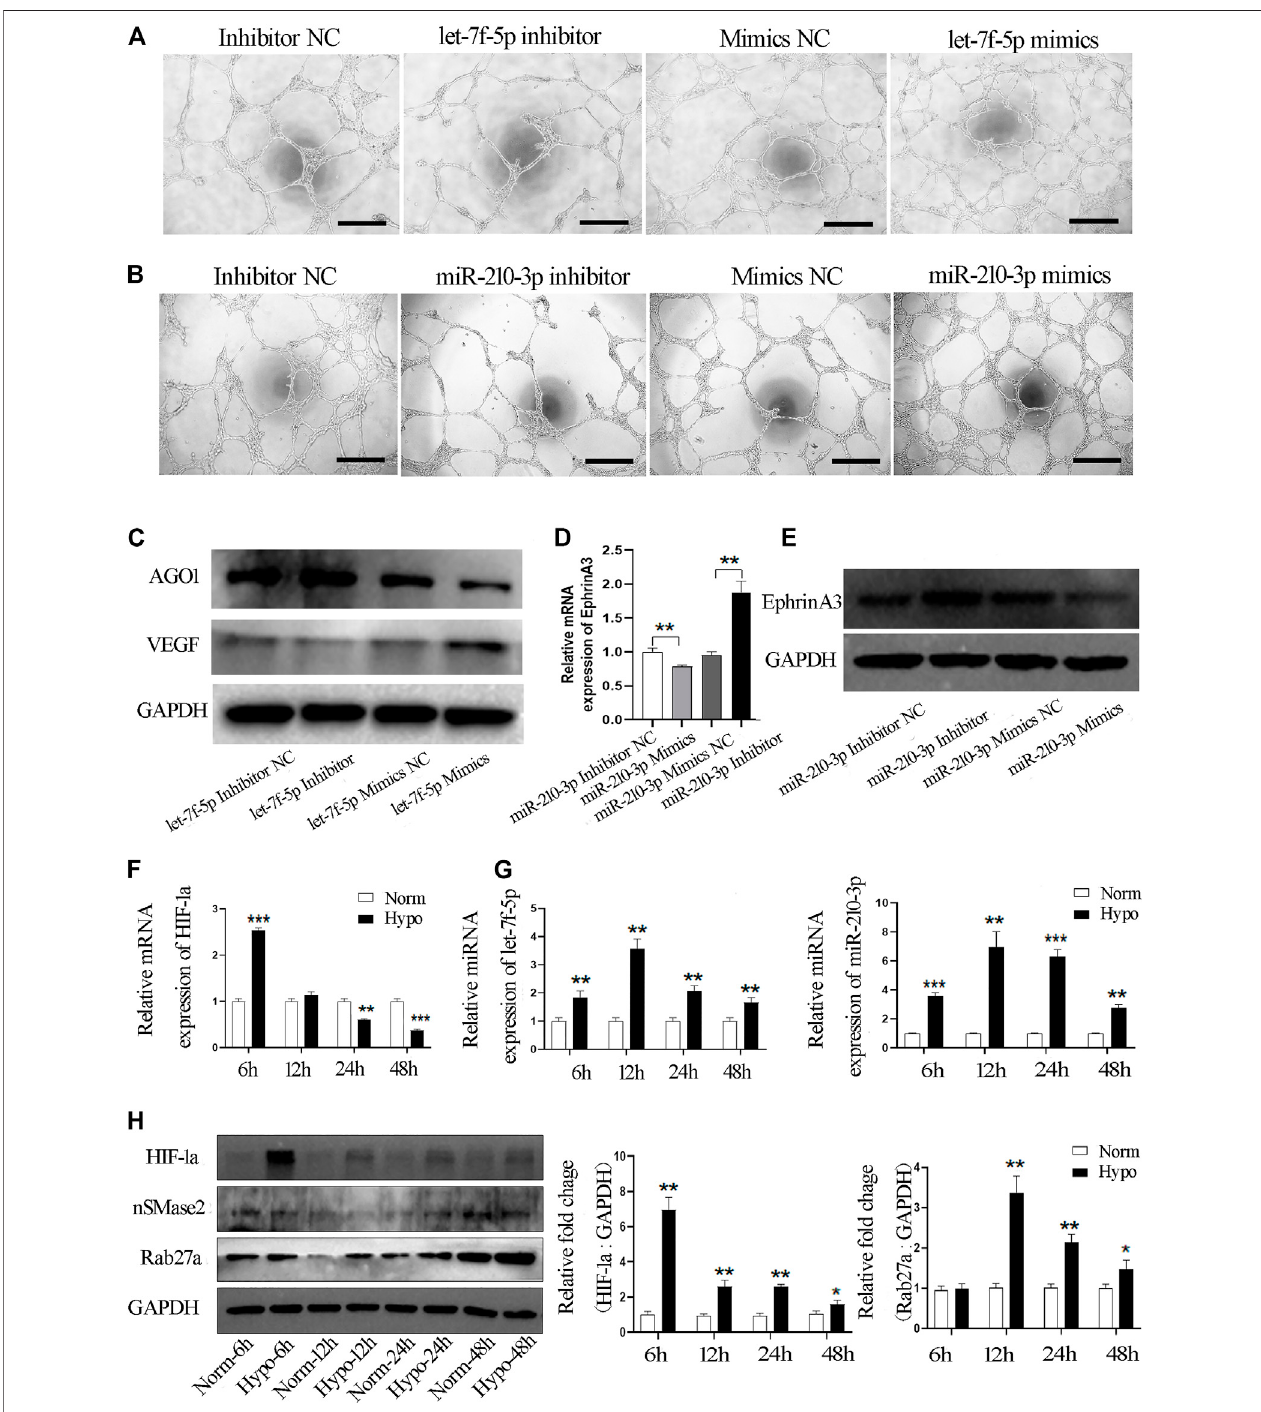
FIGURE 6 | Hypo-exos transfer both let-7f-5p and miR-210-3p to promote the tube formation of endothelial cells. (A) Matrigel tube formation assay of HUVECs transfected by mimics, inhibitor and NC oflet-7f-5p; scale bars = 500 μ m. (B) Matrigeltube formation assay ofHUVECs transfectedby mimics, inhibitorand NC ofmiR- 210-3p;scalebars=500 μ m. (C) ExpressionofAGO1andVEGFvalidatedinendothelialcellstransfectedbymimics,mimicsNC,inhibitorandinhibitorNCoflet-7f-5pby qRT-PCR. (D) Expression of EphrinA3 validated in endothelial cells transfected by mimics, mimics NC, inhibitor and inhibitor NC of miR-210-3p by qRT-PC. (E) Expression ofEphrinA3 wasveri fi edin HUVECs transfected with mimics, mimics NC,inhibitorand inhibitor NC ofmiR-210-3p by Western blot. (F) Expression ofHIF-1a and (G) let-7f-5p and miR-210-3p in SHED cells exposed to hypoxic treatment at 6, 12, 24, and 48 h veri fi ed by qRT-PCR. (H) Expression of HIF-1a, nSMase 2 and Rab27a in SHED cells exposed to hypoxic treatment at 6, 12, 24, and 48 h veri fi ed by Western blot (left). Quanti fi cation of the relative levels of HIF-1a and Rab27a as relative fold change to the respective control cells (right). * p < 0.05, ** p < 0.01, *** p < 0.001.